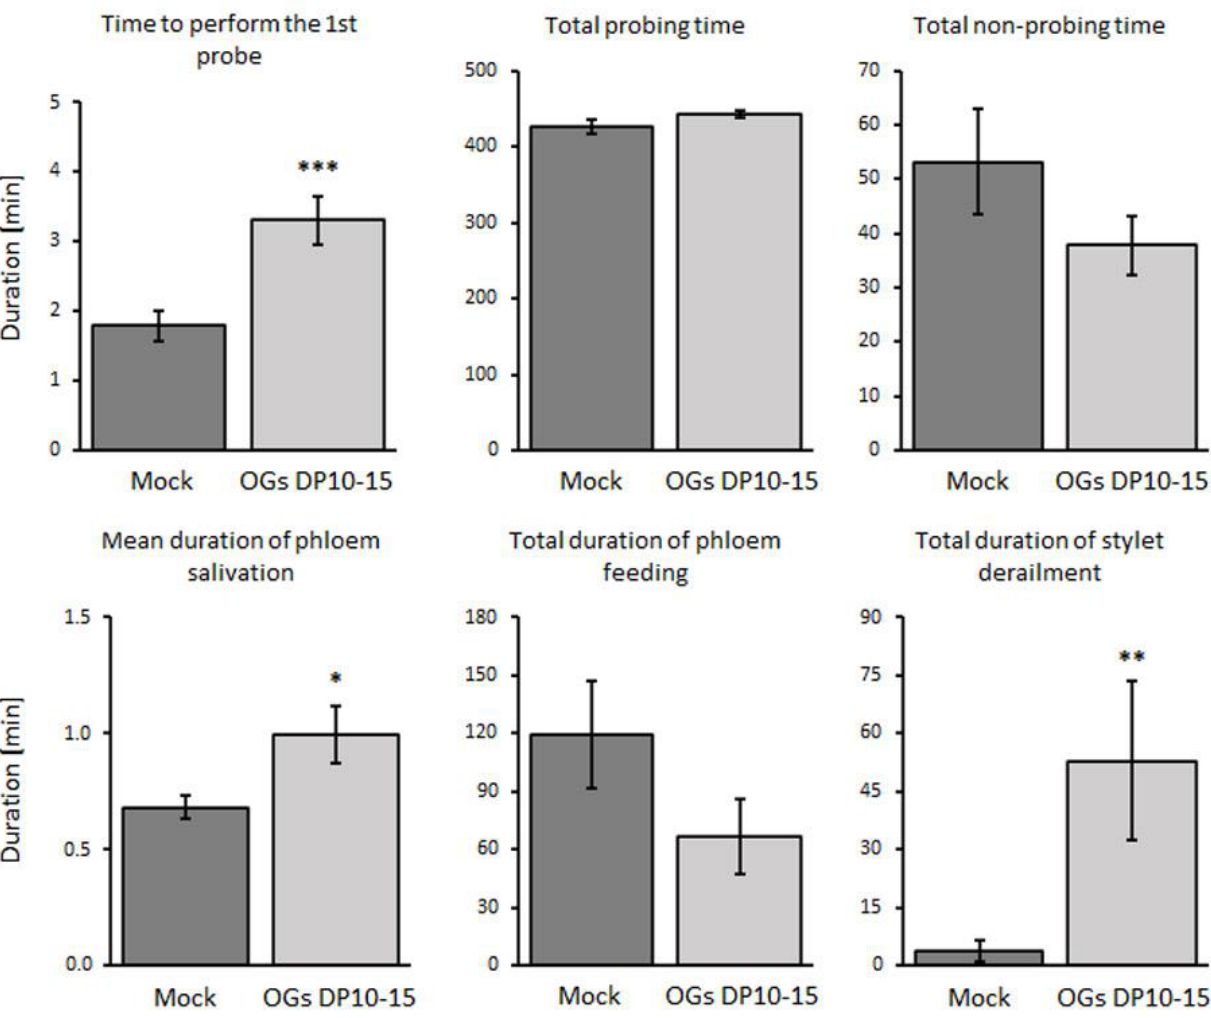
Figure 2. Treatment with OGs negatively alters the feeding performance of aphids. The feeding profiles of M. persicae aphids, on either OG- or mock-treated plants, were analyzed using electrical penetration graph (EPG) assays. Fully expanded leaves of 4-week-old Arabidopsis plants were infiltrated with OGs (DP 10–15; 200 µ g mL − 1 ) or ultrapure water (mock). One adult wingless aphid was placed over the treated leaves, and its feeding profile was recorded using EPG for 8 h. Only data from the 72 hpt timepoint are shown, as the main differences were found at this temporality. The results obtained at 6, 12, and 24 hpt are presented in Supplementary Table S1. Significant differences, indicated by asterisks, were determined using the Student’s t -test or the Mann–Whitney U test, depending on the data distribution of each feeding parameter (i.e., Gaussian or non-Gaussian, determined using the Shapiro–Wilk test). The error bars correspond to standard error. At least 15 independent replicates were assayed for each condition (*, p < 0.05; **, p < 0.005; ***, p < 0.001).